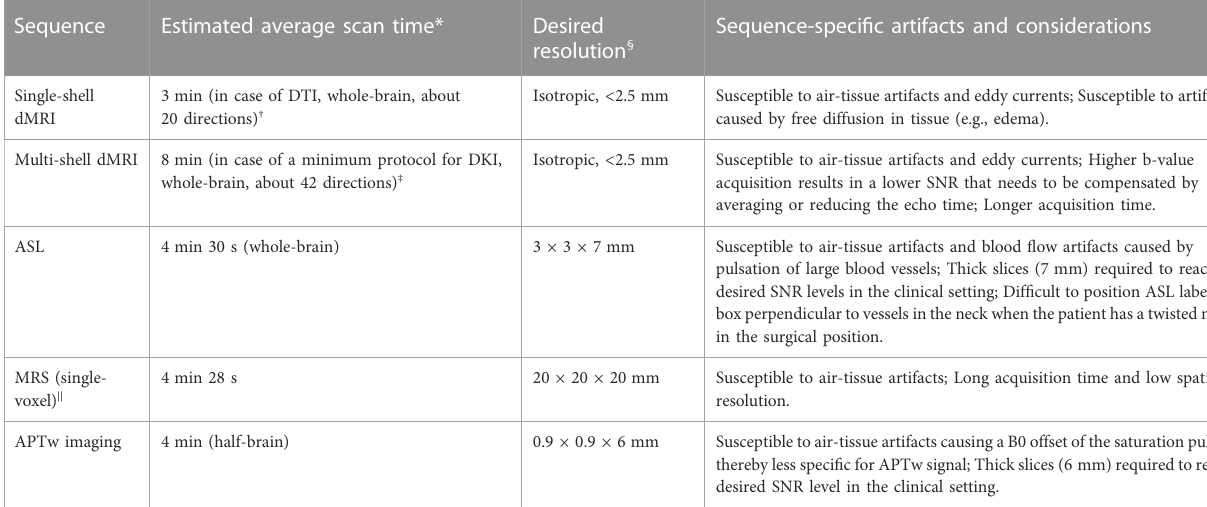
TABLE 3 Technical considerations and details of each advanced MRI